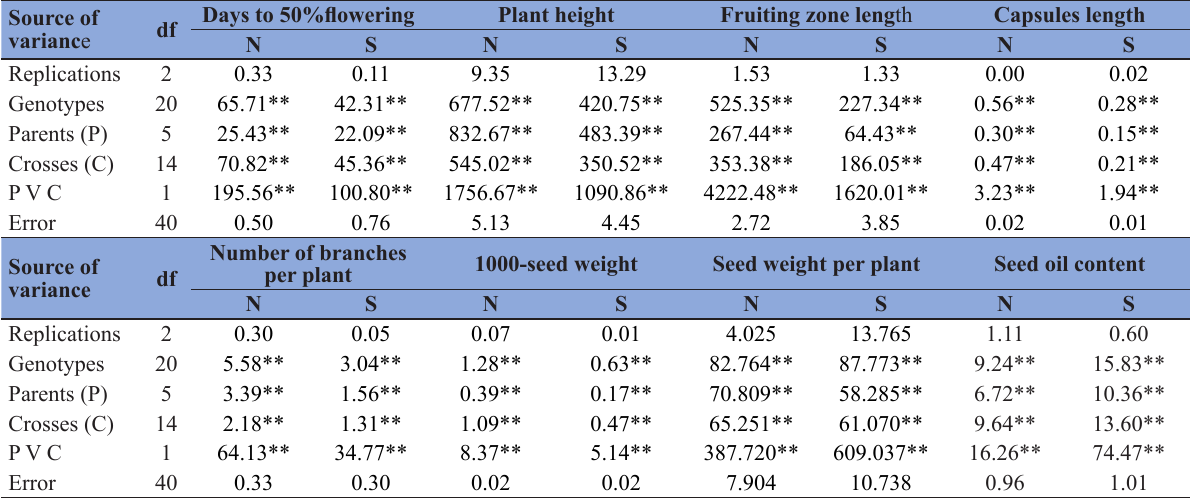
Table 3. Mean squares of the six sesame parents and their F and water stress conditions (S) in 2019 season